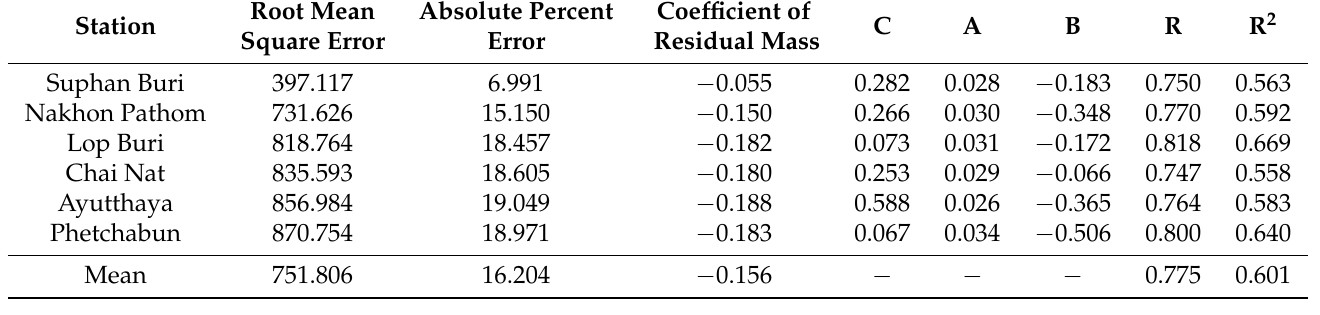
Table 2. Accuracy comparison between the WOFOST model and observed data.